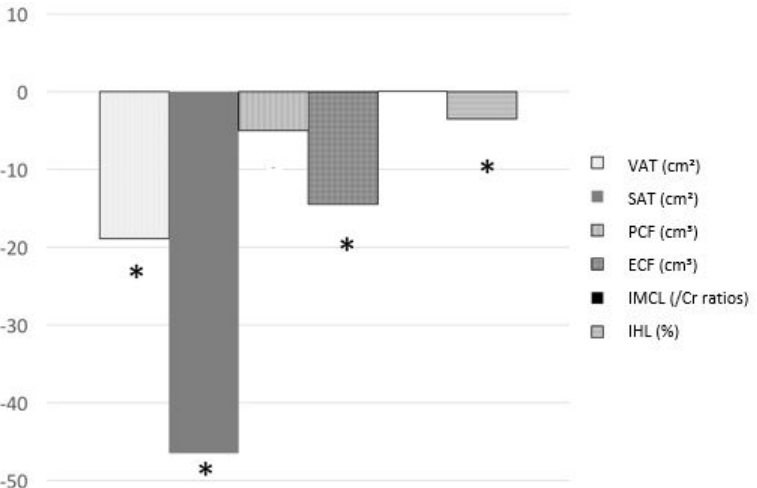
Figure 2. Changes in ectopic fat deposition after a 6-month intervention in the total study sample. VAT-visceral abdominal tissue, SAT-subcutaneous abdominal adipose tissue, PCF-pericardial fat, ECF-epicardial fat, IMCL-intramyocellular lipids, IHL-intrahepatic lipids, * p < 0.05. WC in the total group changed significantly after six months ( p < 0.001). Moreover, TG decreased significantly after six months ( p = 0.003). No significant changes were found for HDL-C ( p = 0.664), FG ( p = 0.633), DBP ( p = 0.605) and SBP ( p = 0.308). Figure 3 shows the changes in the metabolic parameters in the total sample.